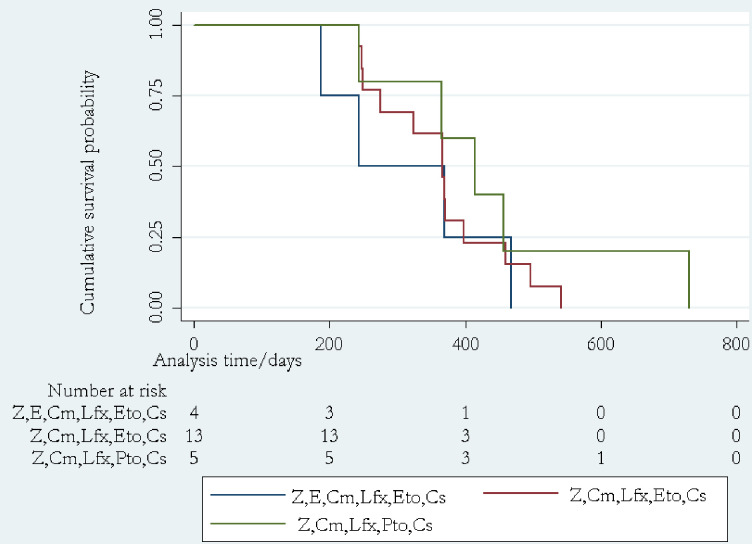
The cumulative survival probability of MDR-TB treated patients with respect to the initial drug regimens at MDR-TB treatment centers of South and Southwest Ethiopia, April 14 to May 14, 2019.